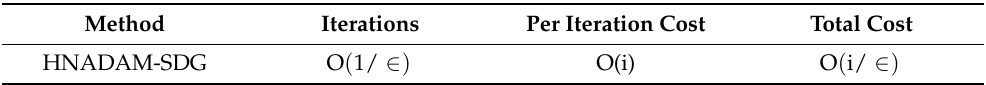
Table 2. Complexity of HNADAM-SDG